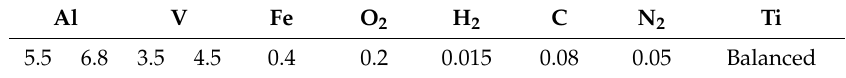
Table 1. Nominal chemical composition of Ti–6Al–4V (wt %).